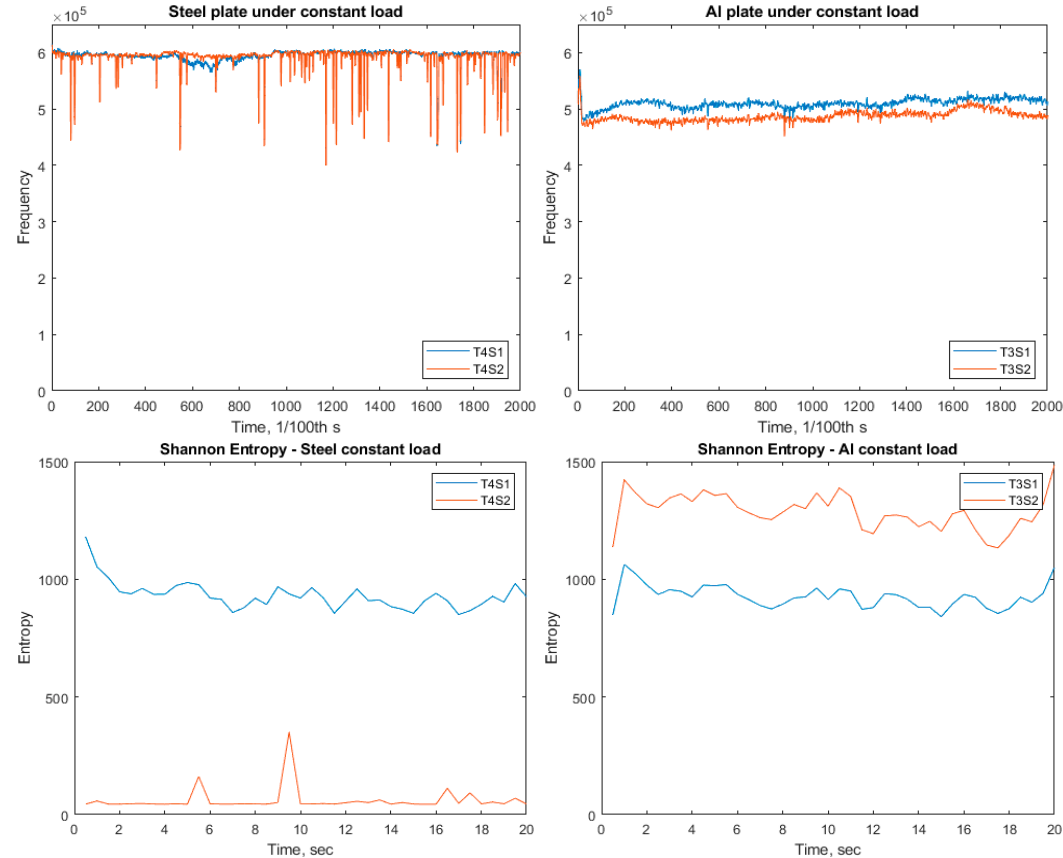
Figure 17. Centroid frequency ( top ) and Shannon entropy ( bottom ) for the constant load tests, after a 300 kHz high pass filter has been applied. As described with the increasing load tests in Section 3.1, the AE hits and counts were measured, but the threshold for the hits was set too low such that noise was sufficient to trigger a hit. Therefore, these data are not considered in this paper. Visual inspection showed that galling did not take place, evidenced by the lack of transferred material from the sample to the indenter, Figure 18. For completeness and to show that the samples were indeed scratched, an example image has been included, Fig- ure 19. Differences are attributed to differing frictional forces between the counter face and the differing material characteristics of each sample, as discussed later.